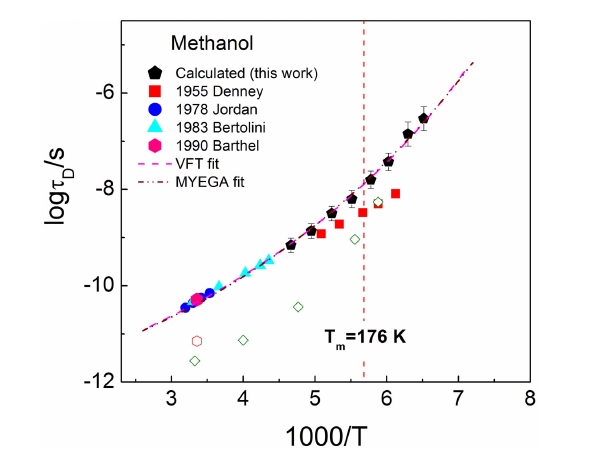
FigUre 9 | activation plot of methanol in temperature range covering normal and supercooled liquids . The data from earlier studies are also shown. The lines are guides for the eye, represented by the Vogel–Fulcher– Tammann equation of log τ D = − 12.4 + 459.4/( T − 74.1) (pink dash line) and Mauro–Yue–Ellison–Gupta–Allan equation of log τ D = − 12.2 + 335.3/ T × exp(144.5/ T ) (green short dash line). The faster α -relaxation times are shown from Barthel et al. (1990) (experimental, open hexagon) and Ngai and Roland (1997) (MD, open